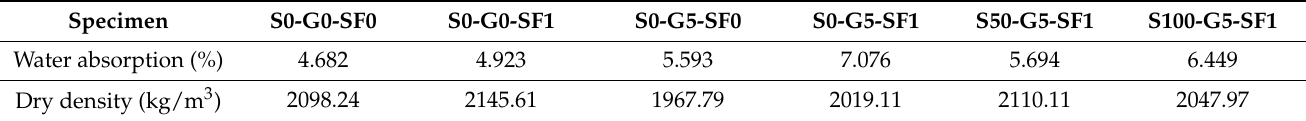
Table 9. Results of the dry density and water